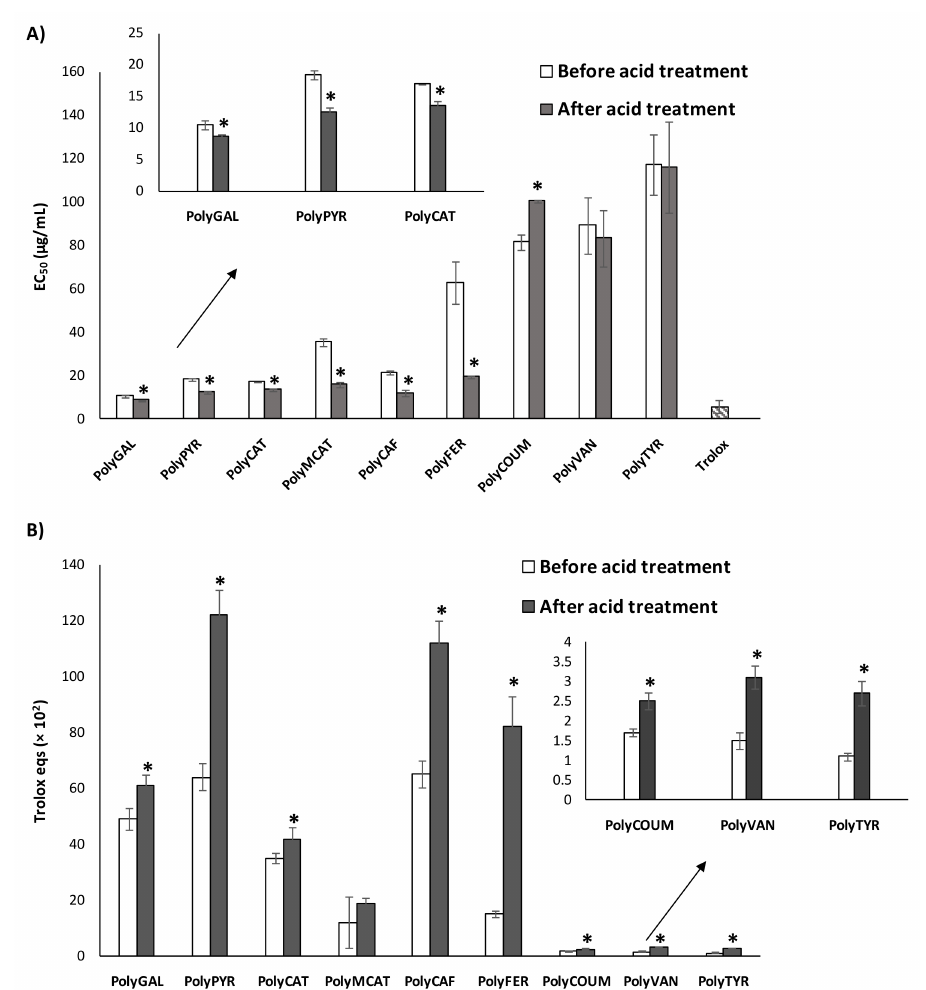
Figure 2. Antioxidant properties of the phenolic polymers before [51] and after acid treatment. ( A ) DPPH and ( B ) FRAP assays. Reported are the mean ± SD values of at least three experiments. Values marked with asterisks are significantly di ff erent from those of the corresponding polymer before acid treatment ( p < 0.05, Microsoft Excel Student’s t